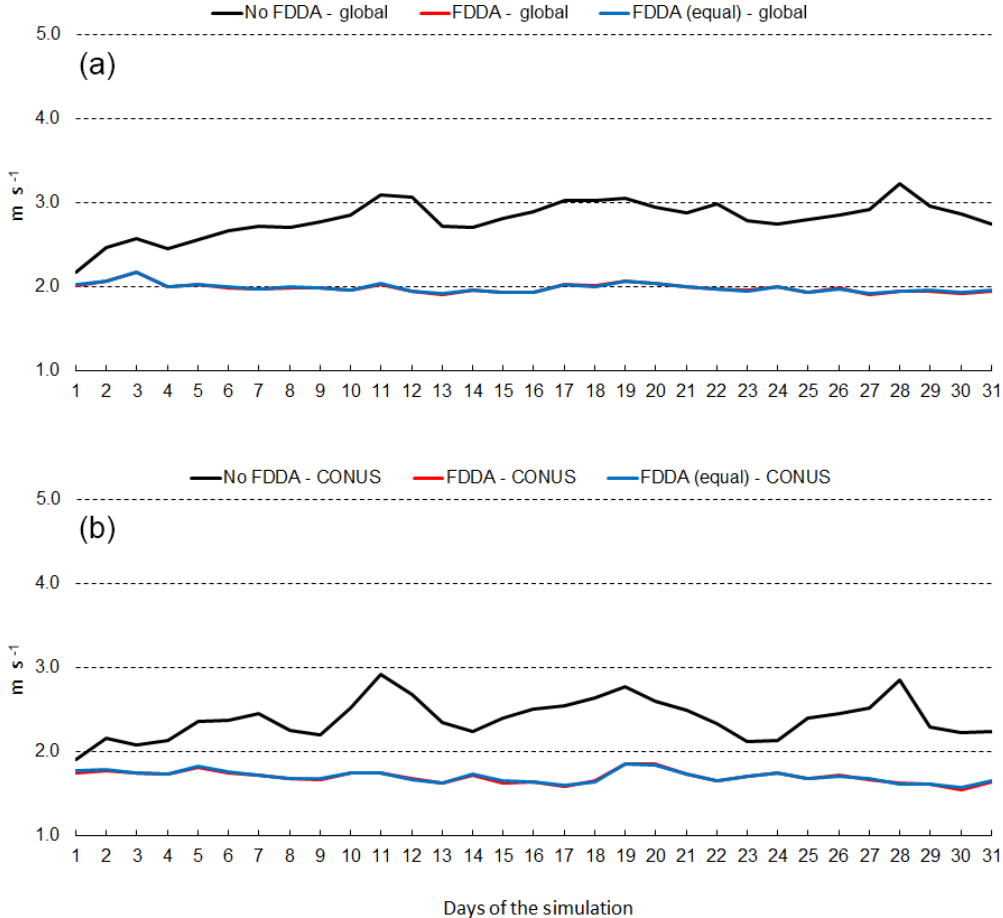
Figure 17. July 2013 time series plots of 10m wind speed RMSE for MPAS-A without FDDA (black line), MPAS-A with FDDA applied using weaker q v nudging (red line), and MPAS-A with FDDA applied at equal strength for all variables (blue line). Panel (a) shows results for the entire global domain, while (b) shows results for the CONUS